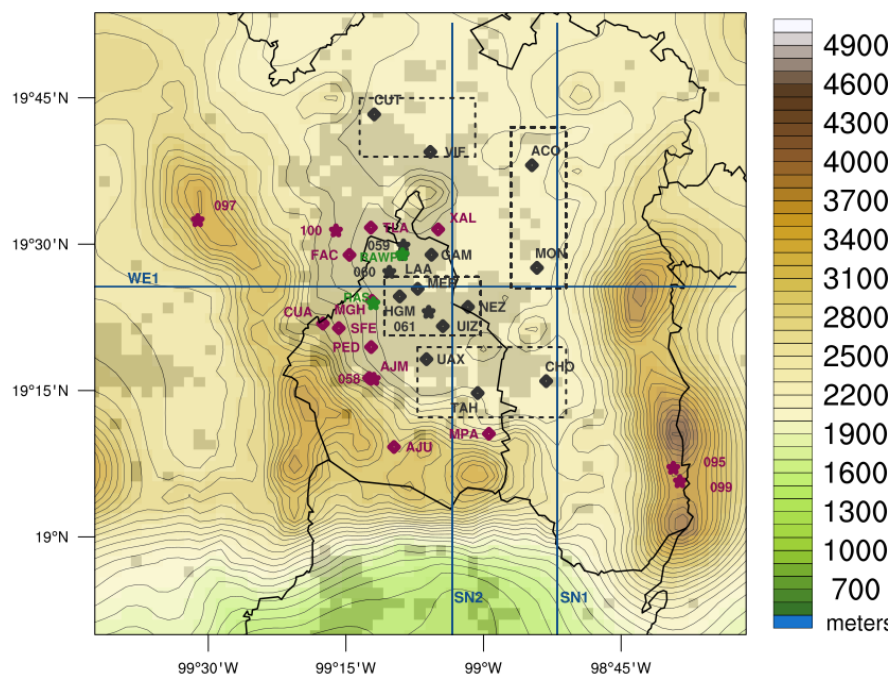
Figure 1. Topography of the Mexico Basin as available from WRF for the innermost computational domain at 2 km spatial resolution, contours every 100 m. Sites with number tags represent SMN surface weather stations and violet and black dots are stations maintained by SEDEMA. The black outline indicates Mexico City limits within the Mexico Basin. Violet dots are all mountain stations located at various elevations within the Mexico Basin. The green dots represent the radiosonde (RAS) and Doppler radar wind profiler (RAWP) positions. Dotted rectangles represent areas of aggregates of surface stations at similar elevations. Lines denoted as SN1 and SN2 represent south- north transects at 98.86 ◦ W and 99.06 ◦ W longitudes and line WE1 represent west-east transect at 19.43 ◦ N, respectively. Light gray pixels represent the area extent of current urban area covered by Mexico City and surrounding towns and